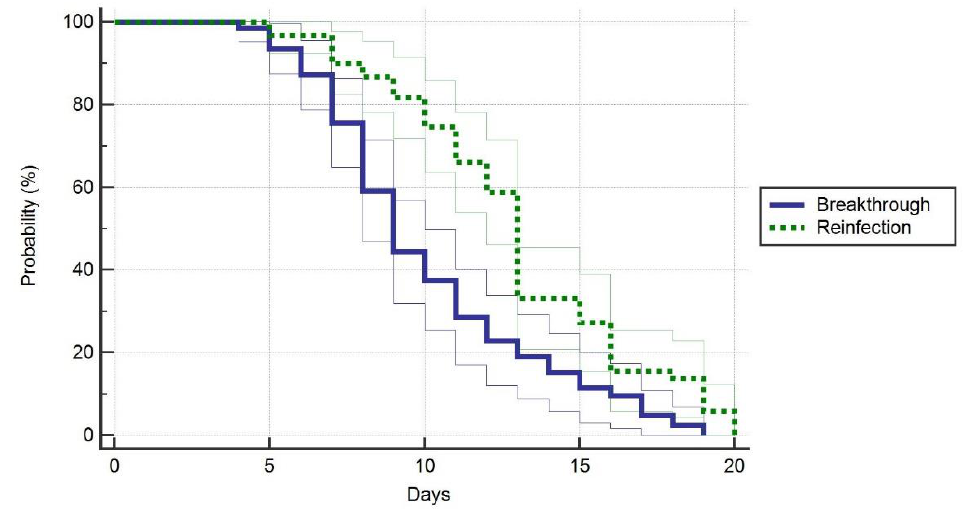
Figure 2. Probability of hospital stay duration in symptomatic patients.